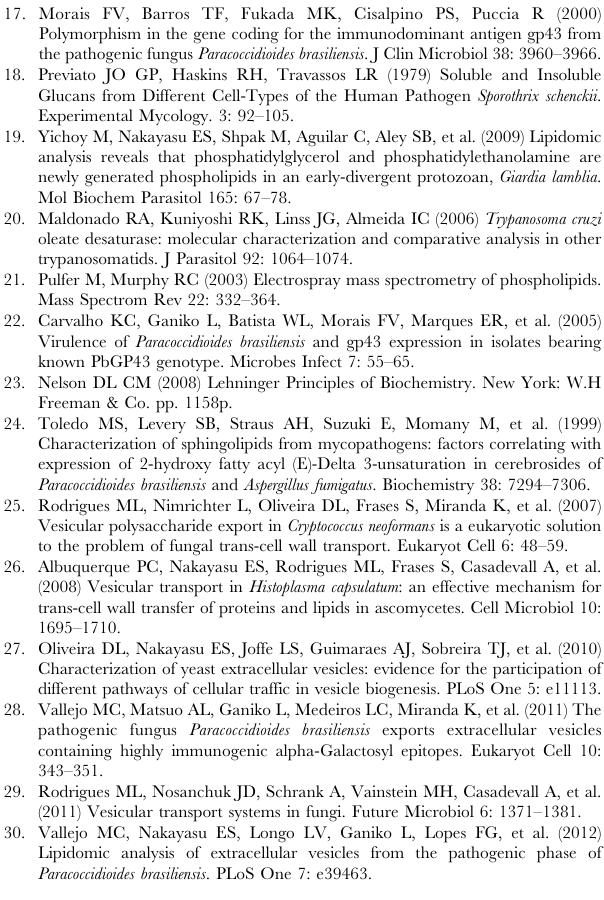
Figure S5 Tandem-MS spectrum of C16:0/C18:2-PI, the most abundant PI species identified in the negative-ion mode. Fragmentation was performed by TIM using PQD and spectra were analyzed manually. GroP, glycerophosphate; Ins, inositol; InsP, phosphoinositol. Assigned peaks are indicated. Figure S6 Tandem-MS spectrum of C16:0/C18:1-PG, the most abundant PG species identified in the negative- ion mode. Fragmentation was performed by TIM using PQD and spectra were analyzed manually. GroP, glycerophosphate. Assigned peaks are indicated. Figure S7 Tandem-MS spectrum of 16:0/18:2-PA, the most abundant PI acid species identified in the negative- ion mode. Fragmentation was performed by total-ion mapping using PQD and spectra were analyzed manually. GroP, glycerophosphate. Assigned peaks are indicated. Figure S8 Tandem-MS spectrum of the glycolipid Hex- C16:0-OH/d19:2-Cer identified at m/z 848.7. Fragmen- tation was performed in the positive-ion mode by TIM using PQD and spectra were analyzed manually. Assigned peaks are indicated. Figure S9 Tandem-MS spectrum of the glycolipid Hex- C18:0-OH/d18:2-Cer identified at m/z 862.8. Fragmen- tation was performed in the positive-ion mode by total-ion